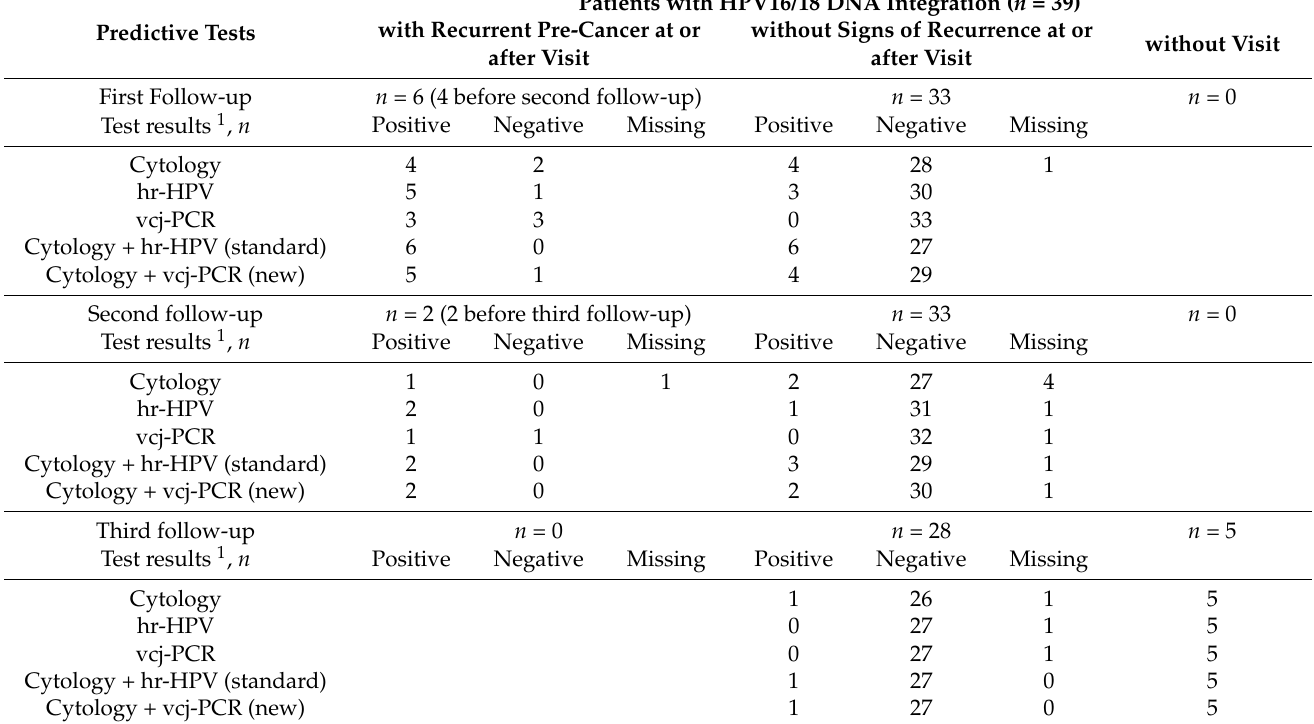
Table A1. Test results in patients with HPV16/18 DNA integration according to recurrent disease (CIN2+) at visit or afterwards (Step 2 analysis population). Patients with recurrence finished study participation after detection of CIN2+ during follow-up and were treated according to current German